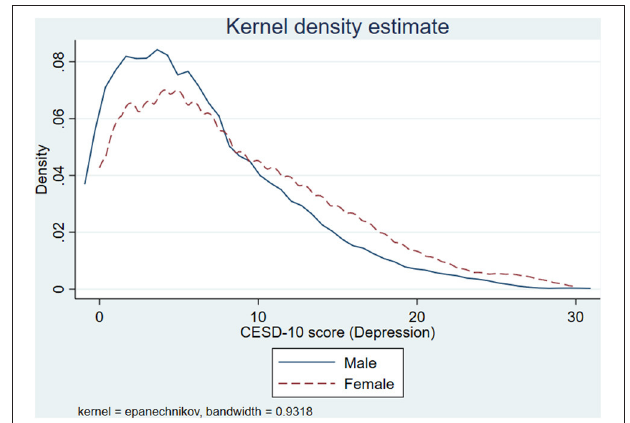
FIGURE 1 | The distribution of CESD-10 scores by